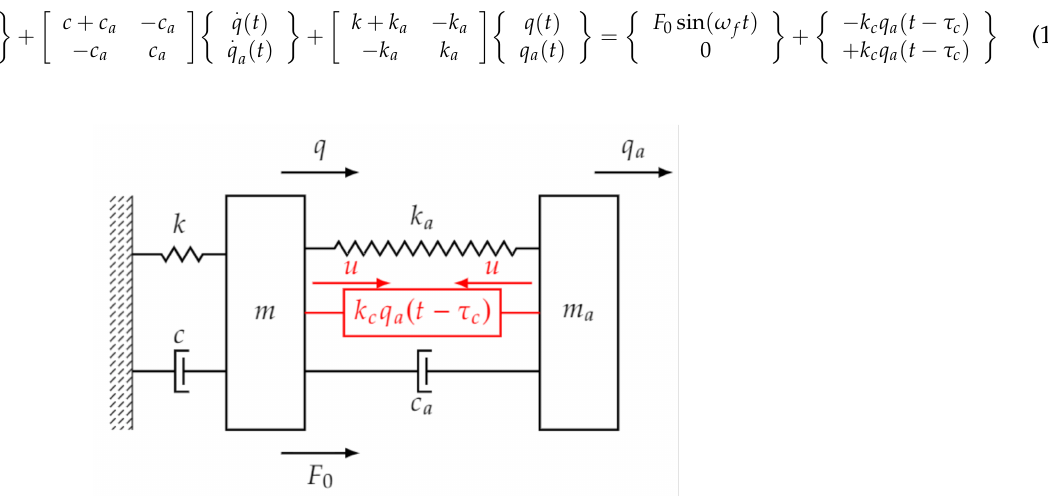
Figure 4. Sketch of the delayed